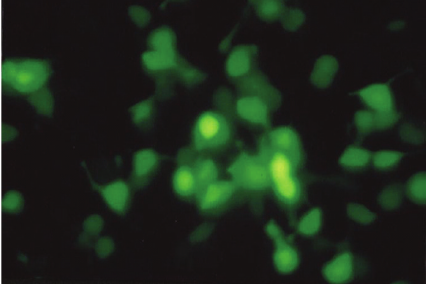
Figure 4: GFP expression in target cells infected with vAd-2A.